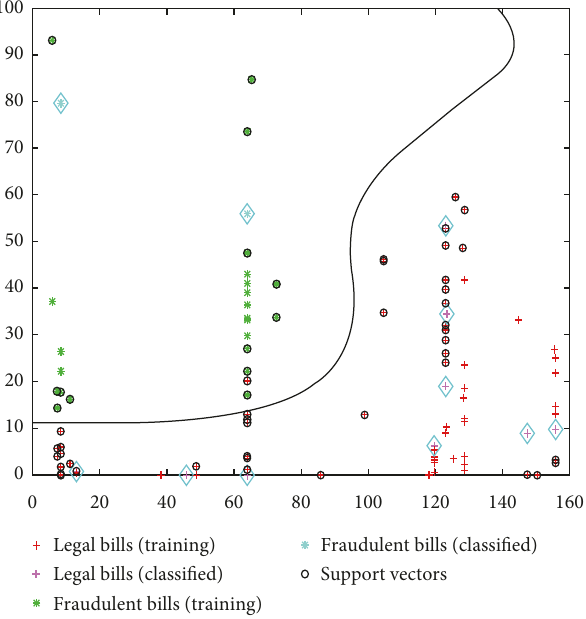
Figure 13: RBF SVM on a sample claims dataset. Table 4: Averages performance analysis of SVM classifiers.